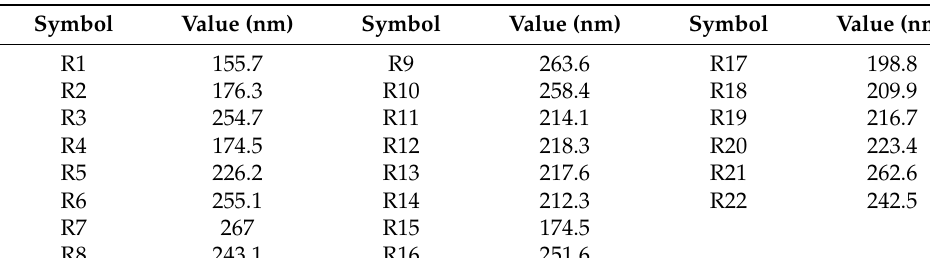
Table 3. Radii of the silicon columns for the maximum FoM values.